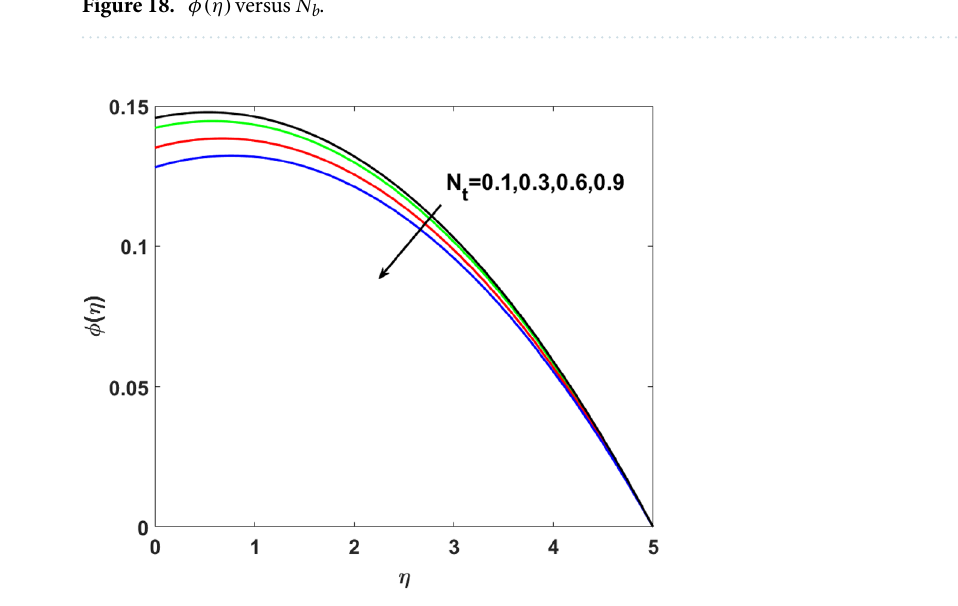
Figure 19. φ(η) versus N t